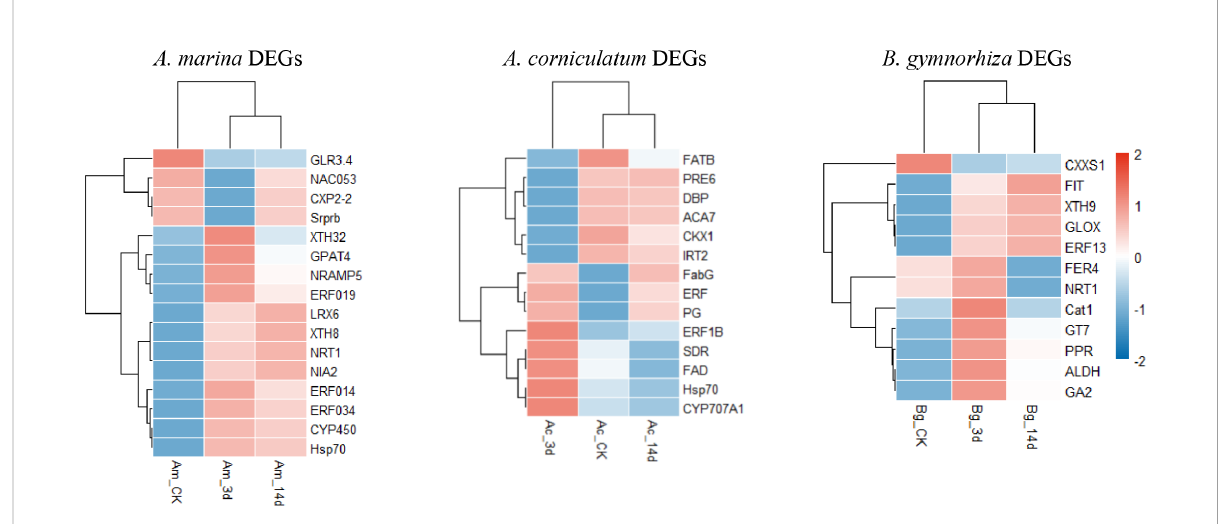
FIGURE 4 Differentially expressed genes (DEGs) information and Gene Ontology (GO) enrichment of Avicennia marina , Aegiceras corniculatum , and Bruguiera gymnorrhiza .